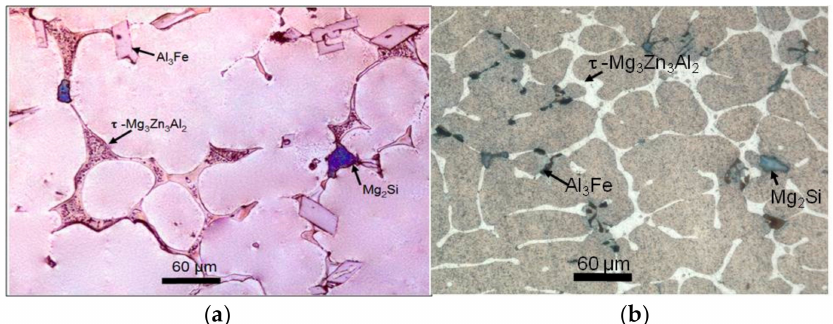
Figure 1. Images of the samples with the di ff erent attacks employed: ( a ) Keller, ( b ) Gra ff -Sargent. Detected phases are identified.